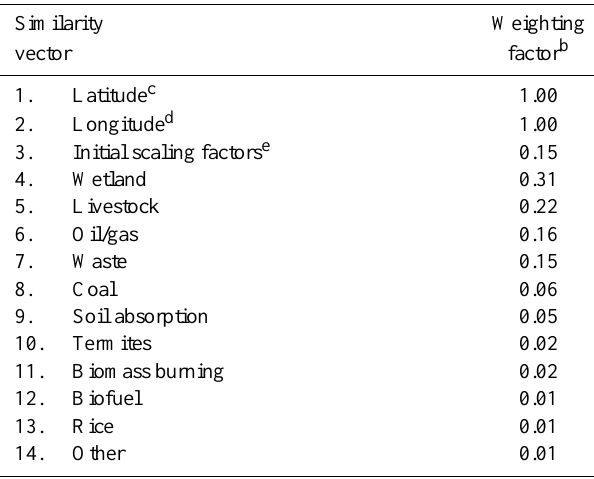
Table 1. Similarity vectors for inverting methane emissions in